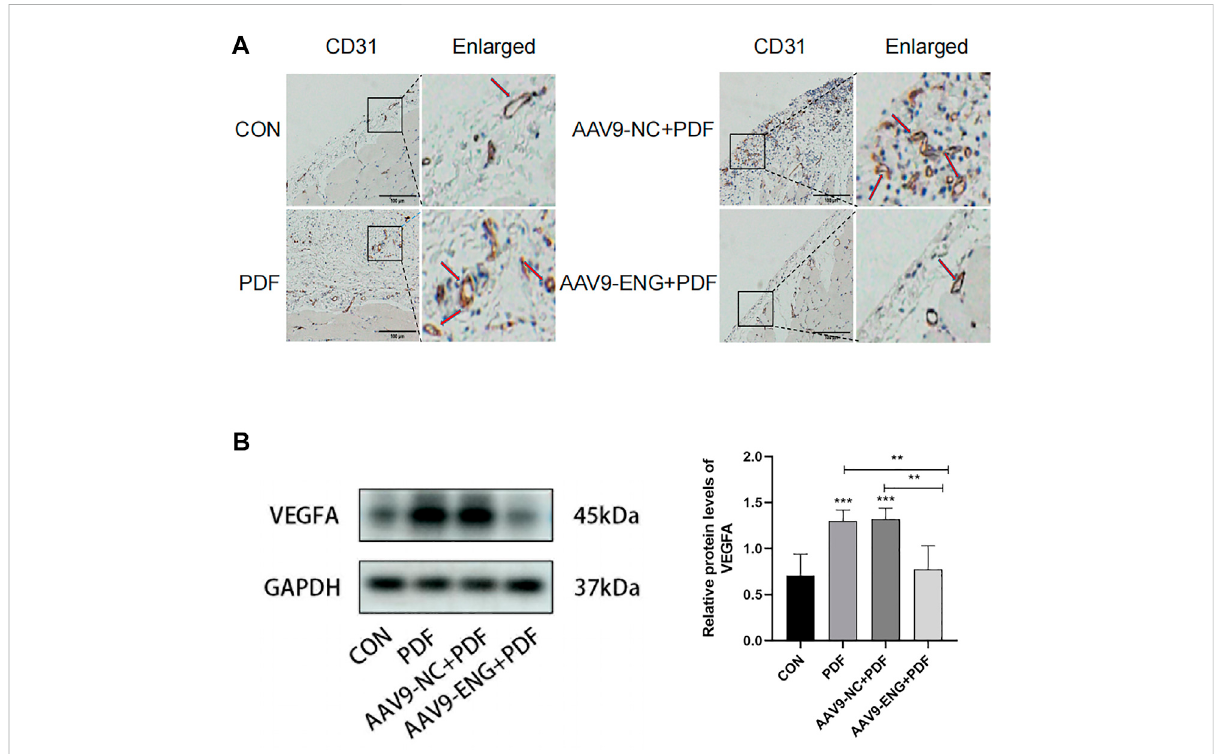
FIGURE 3 Angiogenesisin endoglin knockdown rat. (A) Representativeimmunohistochemical staining imagesof CD31 indifferent groups of rats. The red arrows indicate hyperplasticblood vessels.Scale bar= 100 μ m. (B) VEGFAproteinlevels indifferent groups. n =6. Allquantitative data are expressed as mean ± SD, * p < 0.05, ** p < 0.01, *** p <